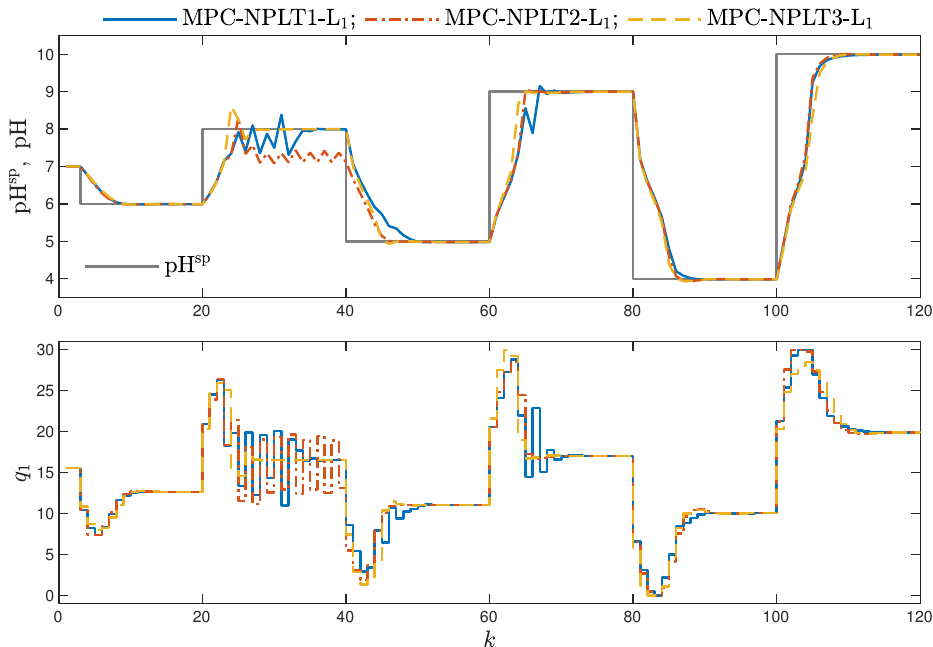
Figure 3. Simulation results: the MPC-NPLT1-L 1 , MPC-NPLT2-L 1 and MPC-NPLT3-L 1 algorithms.